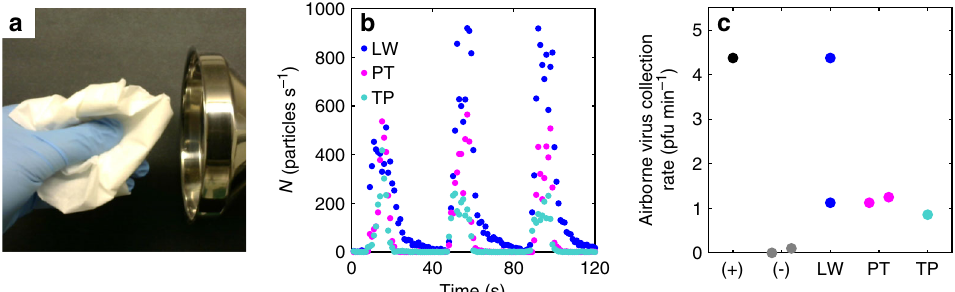
Fig. 4 Paper tissues contaminated with Pan99 virus release infectious aerosolized fomites. a Manually rubbing paper tissues in front of a stainless-steel funnel attached to the aerodynamic particle sizer (APS) (see also Supplementary Movie 2). b Instantaneous particle emission rate vs. time, measured by APS, produced by rubbing three different types of paper tissues, lab wipe (LW), paper towel (PT), and toilet paper (TP). The positive control (Pan99 virus at 200 pfu ml − 1 , aerosolized by a nebulizer directed into the funnel) is indicated by ( + ), and the negative control (air sampling without virus aerosolization) is indicated by (-). Rates represent the total of all particles detected in the size range of 0.3 – 20 μ m (Supplementary Fig. 3). c Quanti fi cation by plaque assay of viable airborne viruses (pfu min − 1 of air sampling), collected while rubbing virus-contaminated paper tissues in front of a BioSpot bioaerosol sampler (Supplementary Fig. 7). Source data are provided as a Source Data